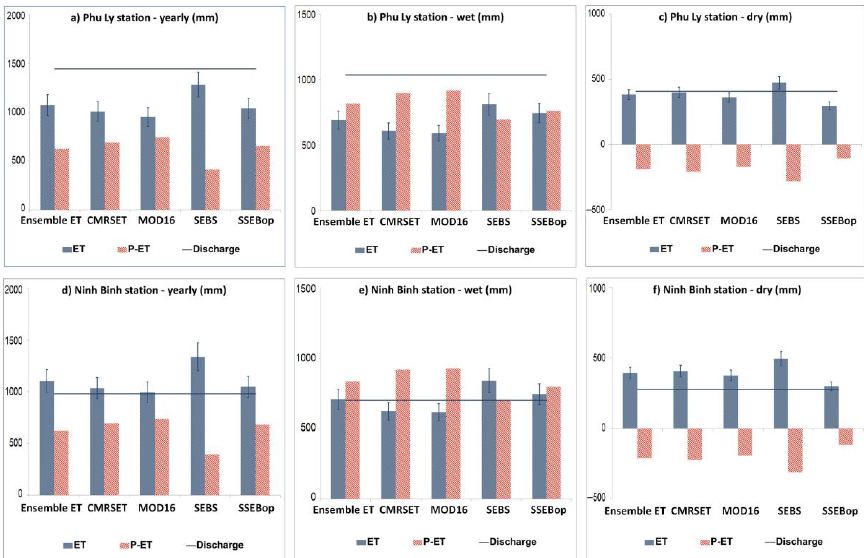
Figure 4. Comparison of accumulated evapotranspiration (ΣET), rainfall surplus ΣP-ΣET, and discharge ΣQ over the 2007 to 2010 period at yearly ( a , d ), wet months ( b , e ), and dry months ( c , f ) at two stations, Phu Ly and Ninh Binh.